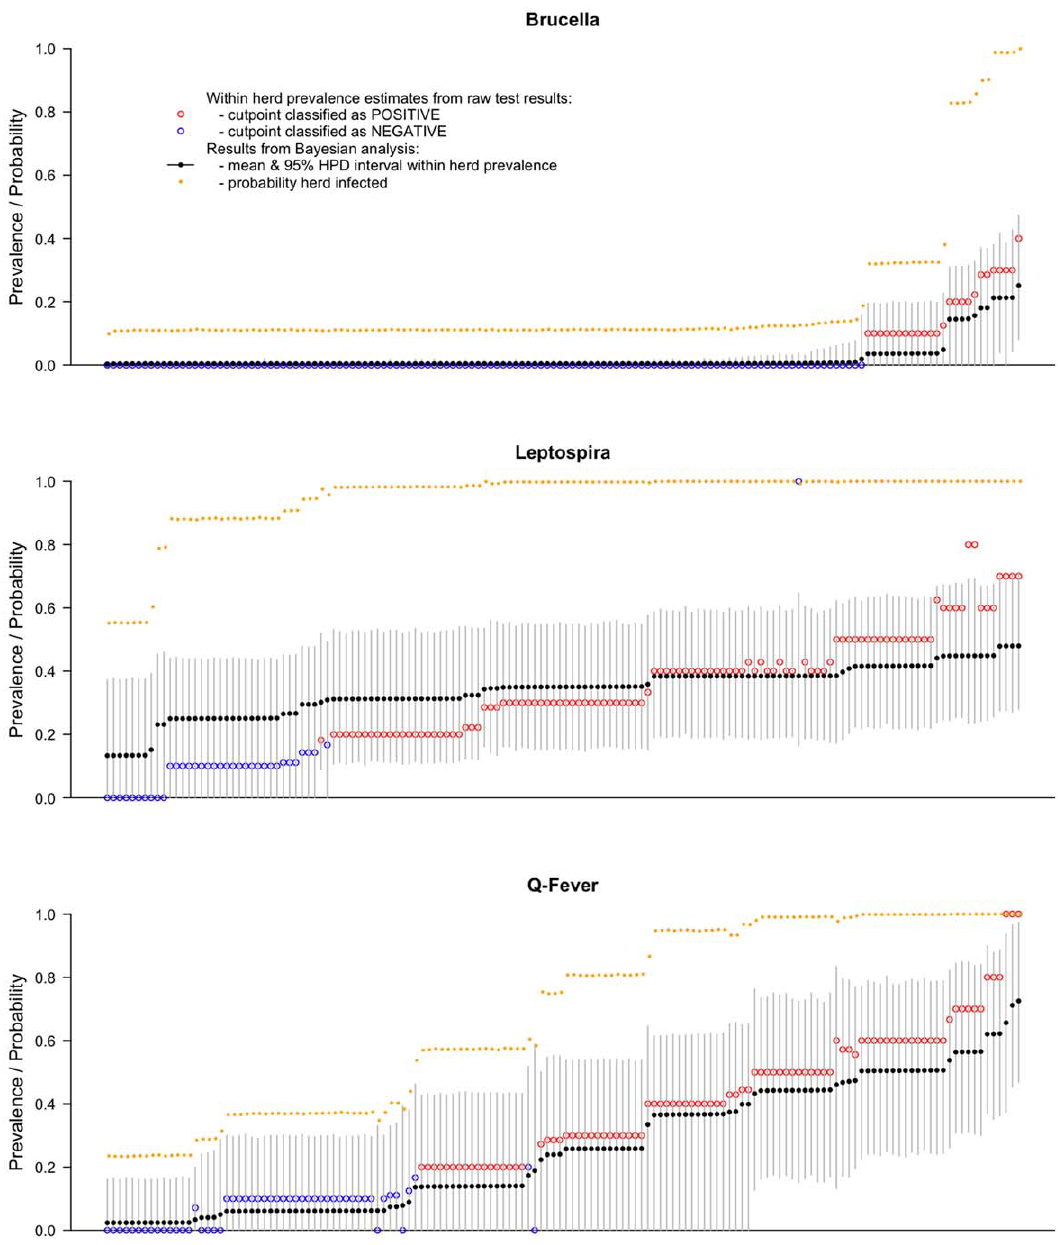
Figure 5. Caterpillar plots showing the classification of each of the 146 herds based on the raw test results and the Bayesian seroprevalence model estimates of true within herd seroprevalence with 95% highest density intervals. Herds are ordered along the x axis based on the estimated within herd seroprevalence.